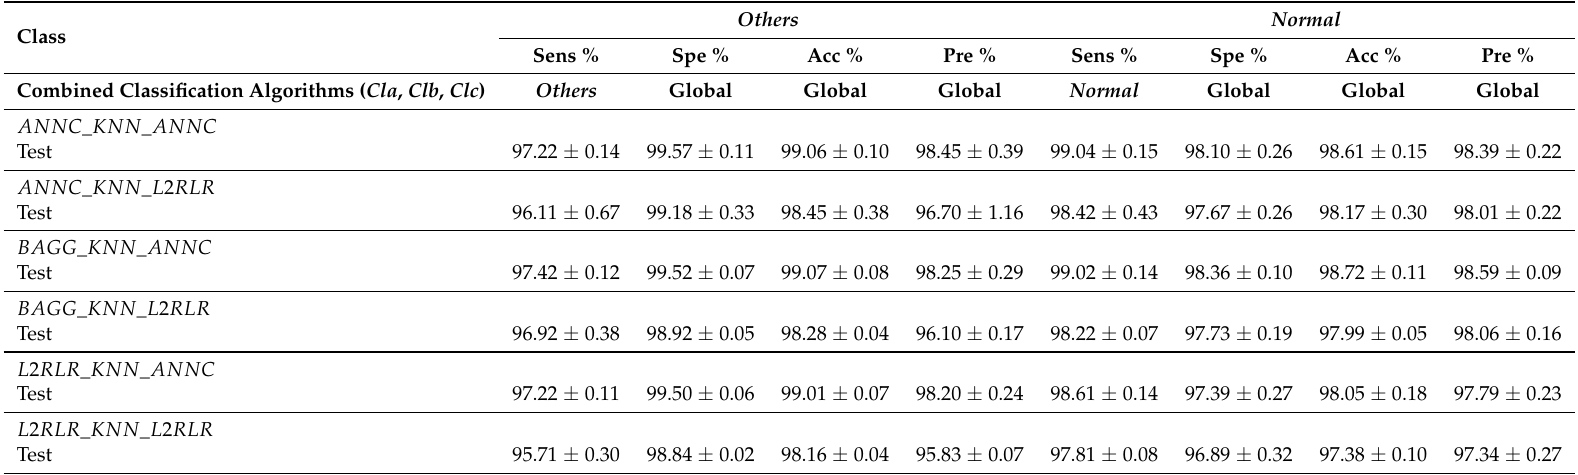
Table 10. Results for different HM combined classifier methods to detect Normal and Others